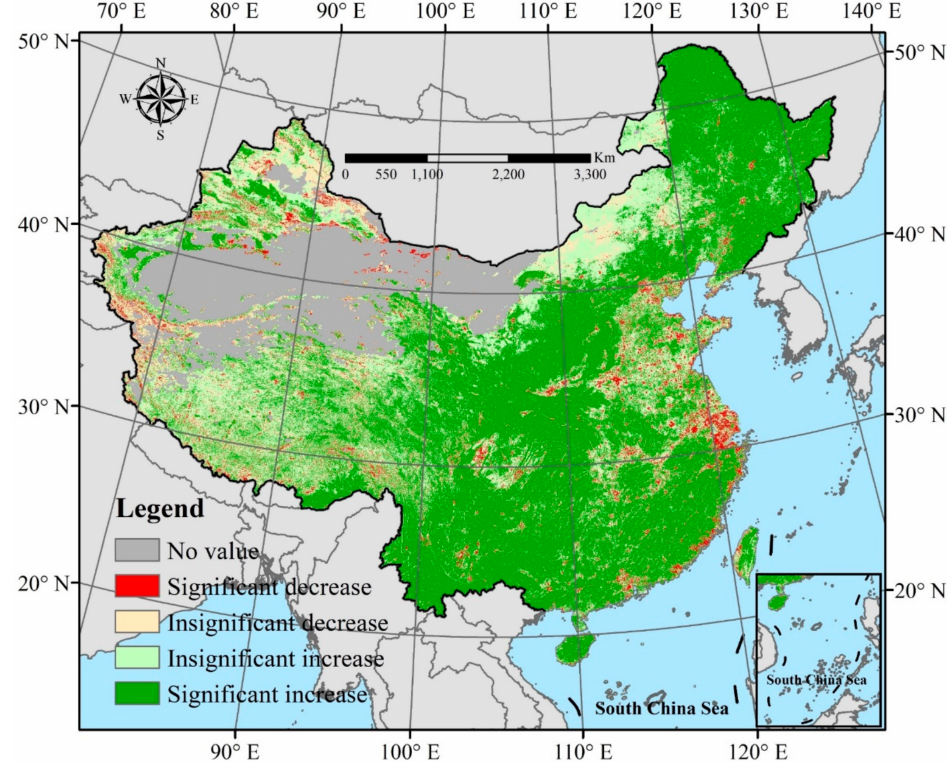
Figure 3. Changes in vegetation cover from 2000 to 2018 based on